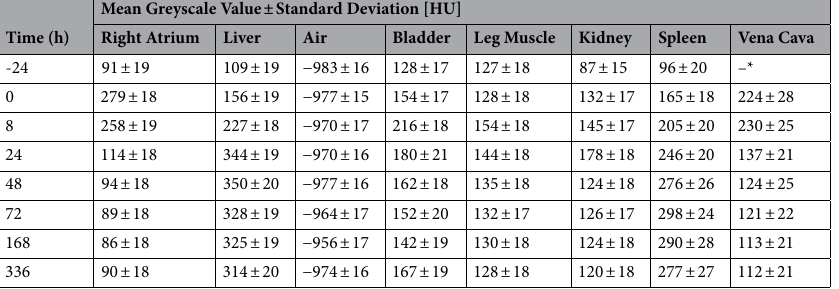
Table 1. Average greyscale value and standard deviation for Fenestra HDVC. The mean greyscale values and standard deviations in Hounsfield units for the five mice injected with Fenestra HDVC. Asterisk (*) indicates an inability to locate the vena cava at that specific time point.